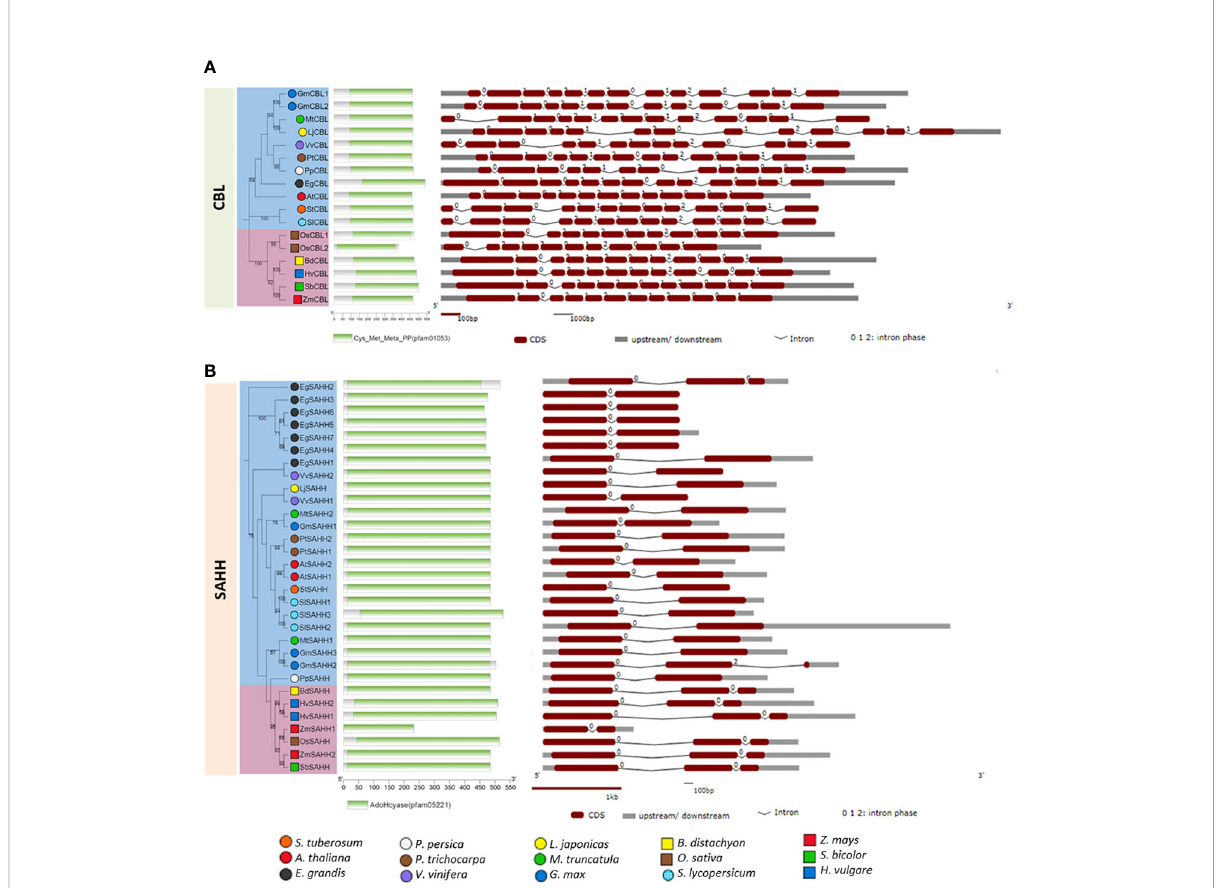
FIGURE 2 Phylogenetic relationship, conserved protein domains and gene structure of CBL (A) and SAHH (B) genes in various plant species. The phylogenetic trees were constructed via amino acid sequence alignment using ClustalW and the Neighbour-Joining method in MEGA-11, and evolutionary distances were computed using the JTT matrix-based method with the bootstrap test (1000 replicates). The tree was visualized on the iTOLv6 webtool (https://itol.embl.de/). The conserved protein domains were analyzed using the NCBI Batch CD-search webserver